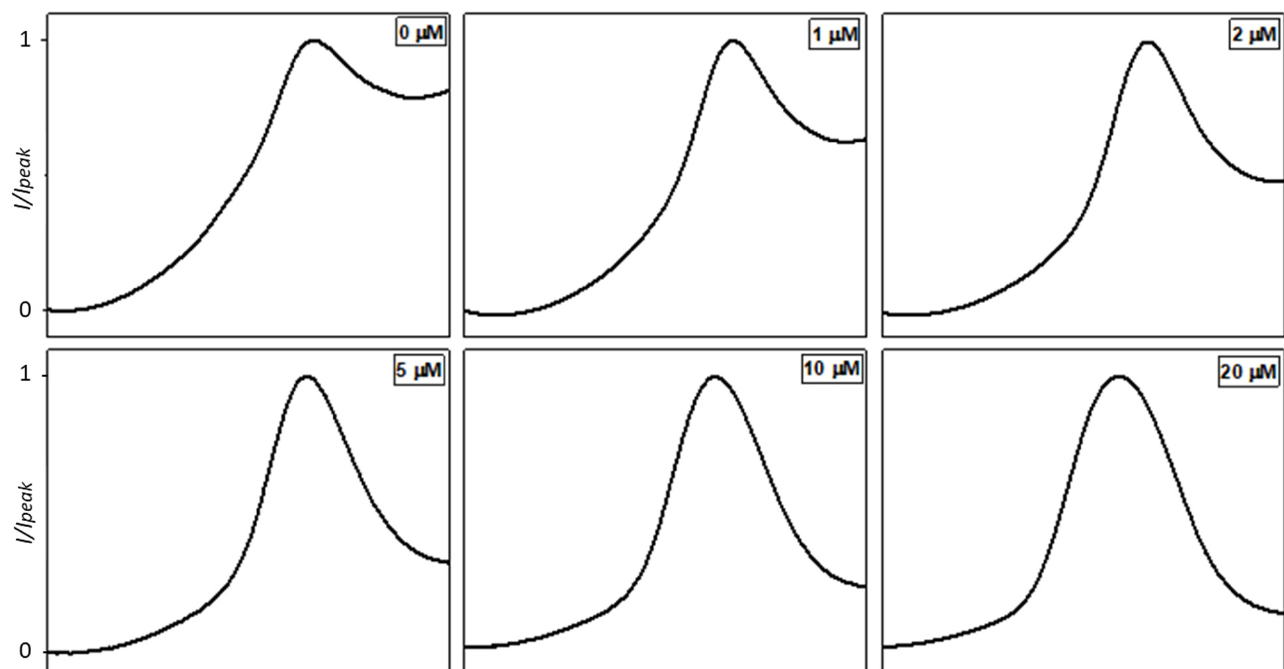
Figure 4. Comparison between normalized peak shapes at different copper ion concentrations in acidic conditions (pH 4).